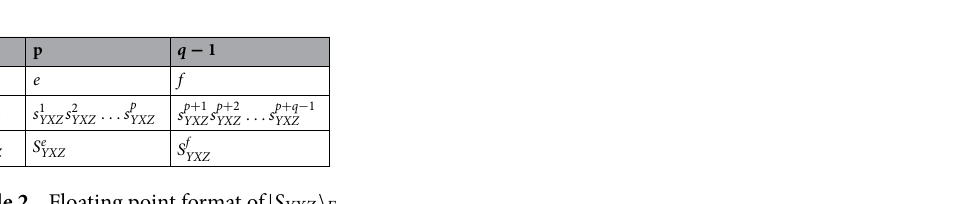
Table 2. Floating point format of